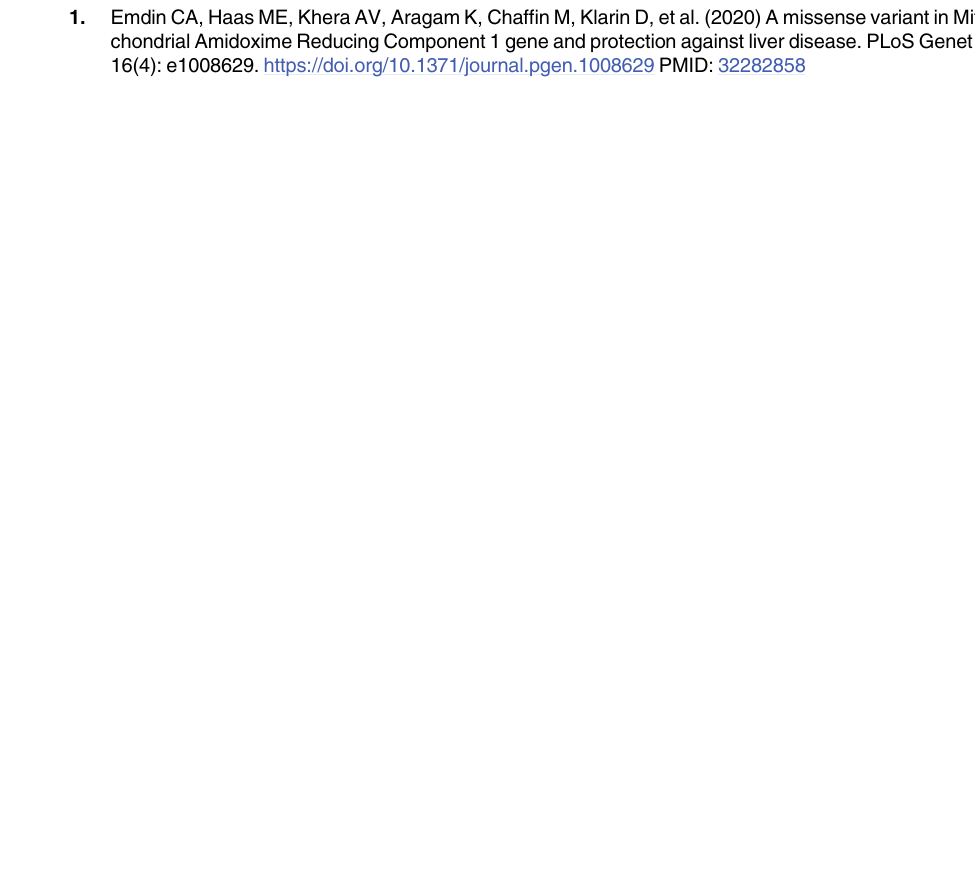
S1 Fig. Risk of alcoholic, non-alcoholic and hepatitis C cirrhosis associated with PNPLA3 I148M, TM6SF2 E167K and HSD17B13.